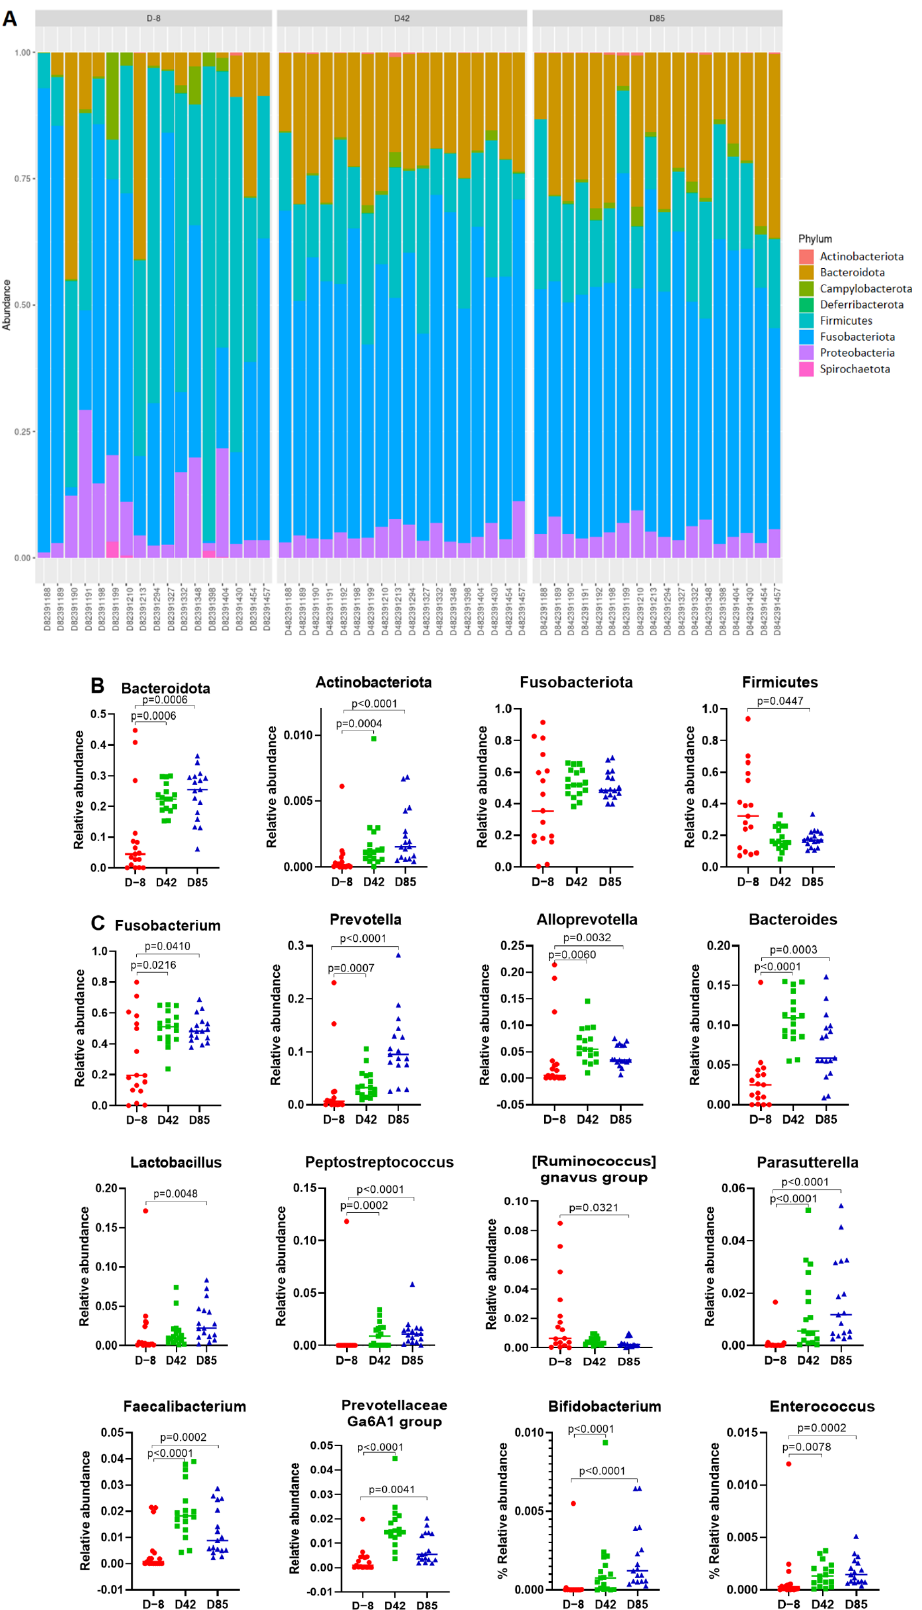
Figure 5. ( A ) Relative abundance of the eight phyla in fecal samples at D−8 (red), D42 (green), and D85 (blue). Differentially abundant phyla ( B ) and genera ( C ) among samples D−8, D42, and D85. Each dot represents a sample. p -values were determined using the Mann-Whitney test. G. intestinalis affects the richness and diversity of the canine gut microbiota. To de- termine the impact of G. intestinalis on the composition of the fecal microbiota, we classi- fied the samples into three categories according to their parasite load: Low, intermediate, and high. The beta diversity of these three categories was then analyzed using Jaccard and unweighted Unifrac distance matrices and was represented through PCoA (Figure 6). In samples D−8 and D42, no difference in the structure of the overall microbiota as a function of parasitic load was observed (data not shown). However, in D85 samples, when the par- asite load spectrum is broader, the samples cluster significantly with the parasite load (low <150,000 cysts/g of feces, intermediate between 150,000 and 750,000 cysts/g of feces, and high >750,000 cysts/g of feces). The parasite load explains 19.18% of the variance using the Jaccard distance (PERMANOVA p = 0.0404) and 23.18% of the variance using un- weighted Unifrac distance (PERMANOVA p = 0.0152). Figure 6. Two-dimensional representation of PCoA plots based on ( A ) Jaccard and ( B ) unweighted Unifrac beta diversity of 16S rDNA genes. Each dot represents a sample, and each color represents a collection time: D−8 (red), D42 (green), and D85 (blue). Axis 1 is the principal coordinate component causing the largest difference in samples, with an explanatory value of 40.4% for Jaccard and 29.3% for Unifrac. Axis 2 was next, with an explanatory value of 15.4% for Jaccard and 24.8% for Unifrac.